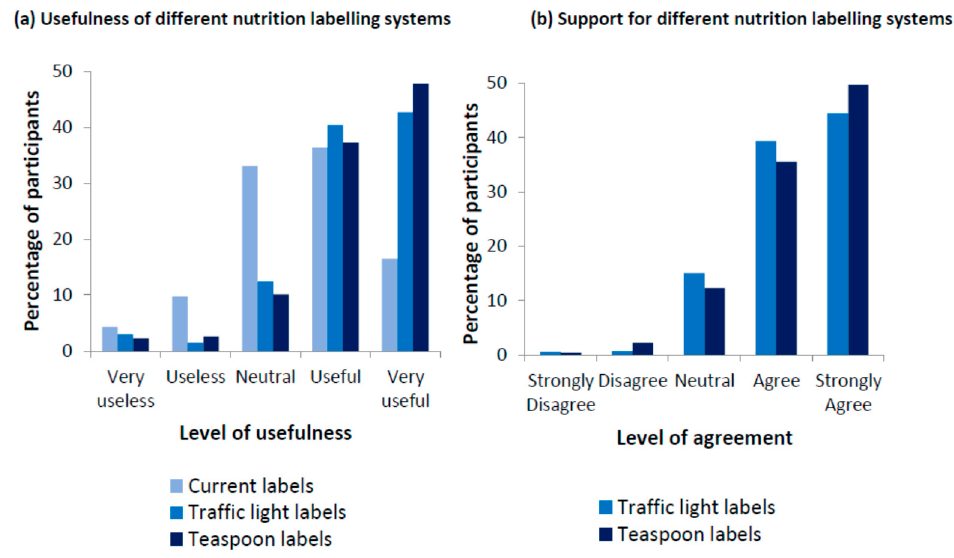
Figure 2. Usefulness of and support for different nutrition labelling systems.